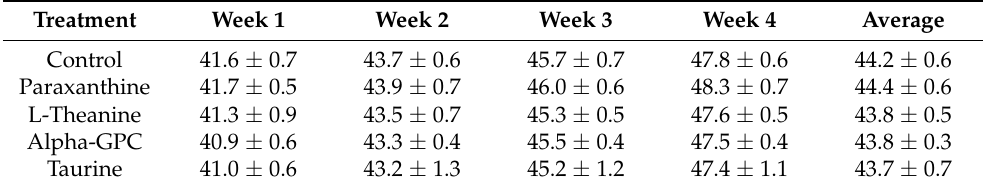
Table 3. Effect of test substance on total feed consumption (in grams). Data are mean ± SD for n = 8 mice in each